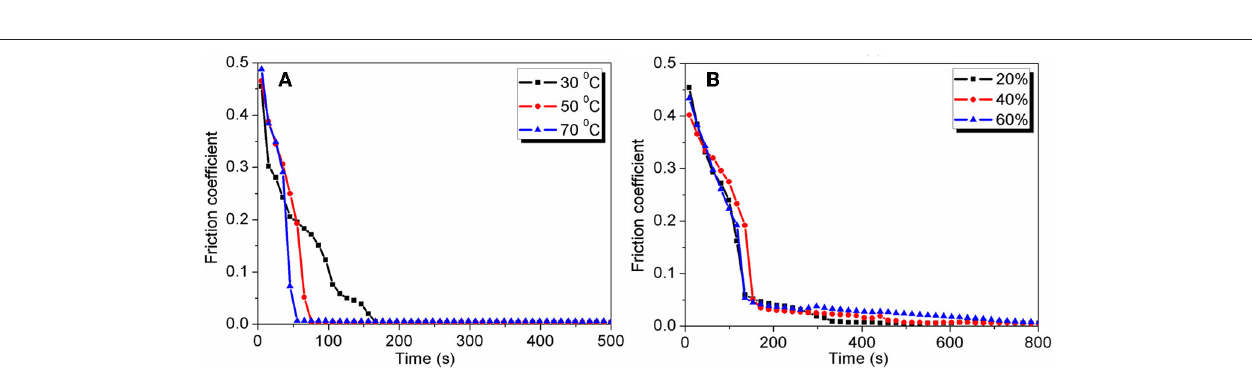
FIGURE 5 | Effects of the temperature and humidity. (A) Evolution of the COF with time under lubrication with H 3 PO 4 (pH = 1.5) at different temperatures, at a humidity of 25%. (B) Evolution of the COF with time under lubrication with H 3 PO 4 (pH = 1.5) at different humidity values, at a temperature of 25 ◦ C. The tribopair is Si 3 N 4 /glass, the load is 3N, and the sliding velocity is 75